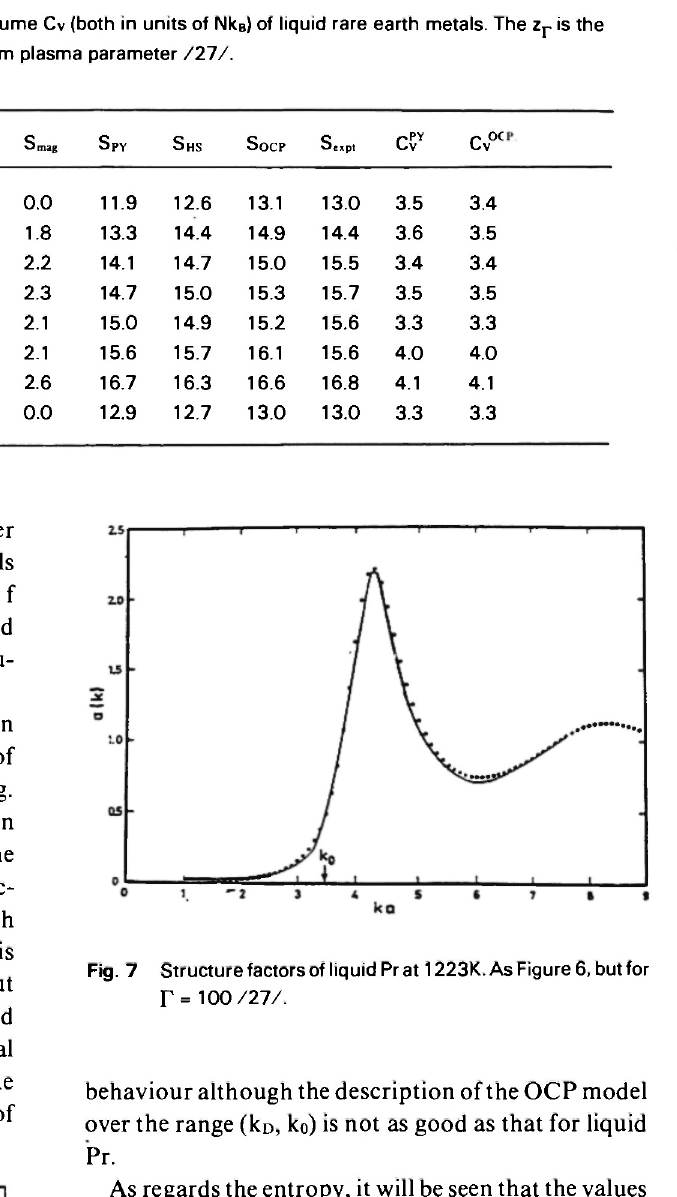
Entropy S and specific heat at constant volume Cv (both in units of Nk B ) of liquid rare earth metals. The z r is the effective valence determined by the optimum plasma parameter /27/.